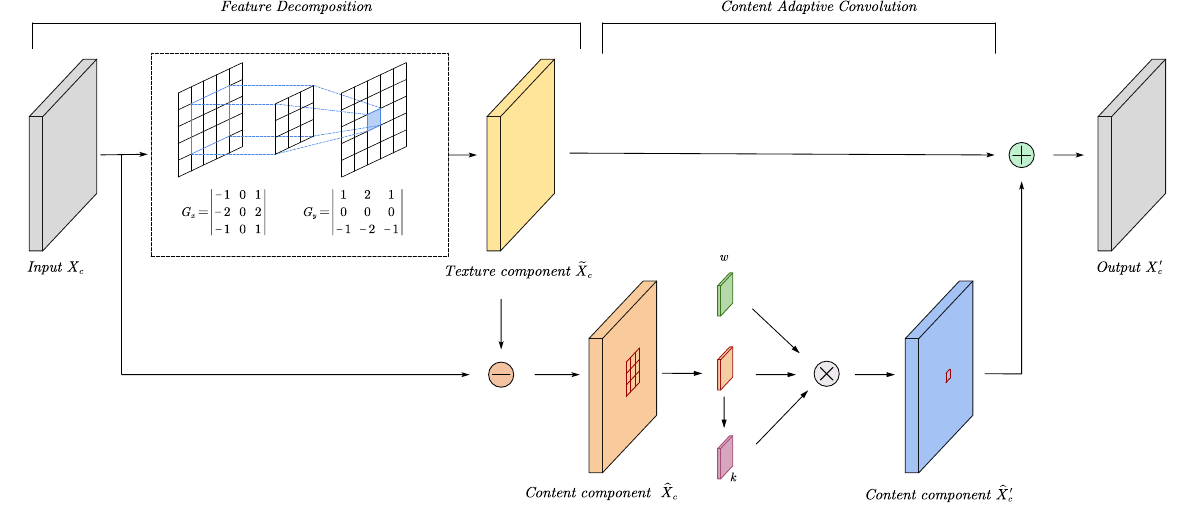
Figure 2. An overview of edge-preserving convolution. The gradient information is obtained via convolution, wherein the kernel weight is fixed as a Sobel operator and is regarded as the texture component. In fact, we can also extract other information from the image, such as the texture features and the curvature. EPC decomposes the input X c into a content component and texture component based on the obtained texture component, and then convolution is performed on the content component (cid:98) X c . The convolution kernel w is modified by the edge-preserving kernel k that is generated from each window in the content component (cid:98) X c ; ⊗ denotes the convolution